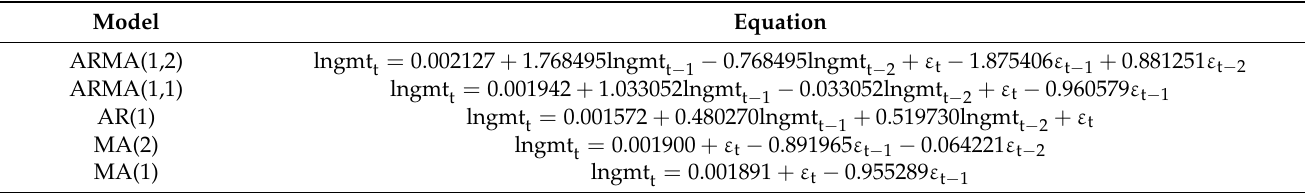
Table 7. Equations of five basic models for fitting global mean temperature from 1961 to 2019.